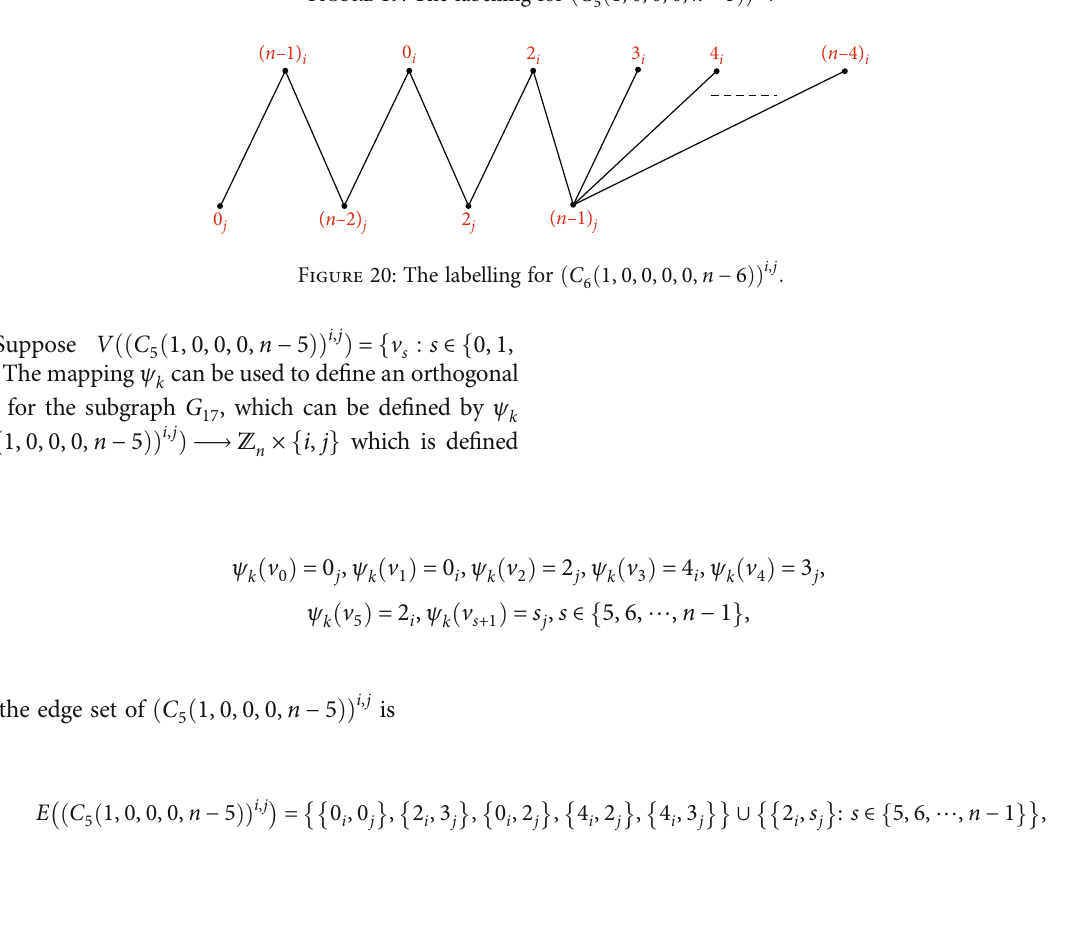
Figure 19: The labelling for ð C